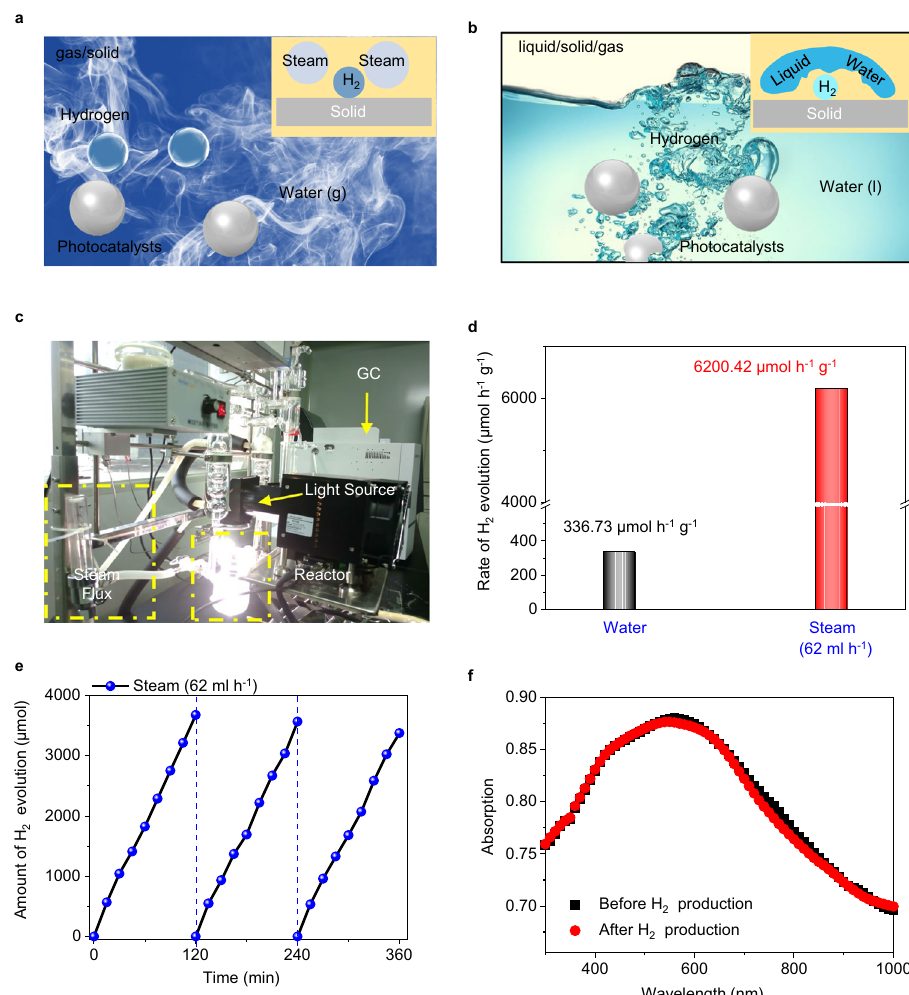
Fig. 3 Schematic and photocatalytic hydrogen evolution performance in the biphase and triphase reaction systems. a Schematic of the biphase system with water steam/solid photocatalysts/hydrogen gas. b Schematic of a typical triphase system consisting of liquid water/solid photocatalysts/hydrogen gas. c Photo of the biphase photocatalytic system. d Photocatalytic hydrogen gas production rate from the triphase and biphase reaction systems. e Time- dependent photocatalytic hydrogen gas production from water steam with a fl ow rate of 62 ml h − 1 . The light source is a solar simulator at AM 1.5 G illumination (100 mW cm − 2 ). f The absorption spectra of CoO NPs before and after hydrogen gas